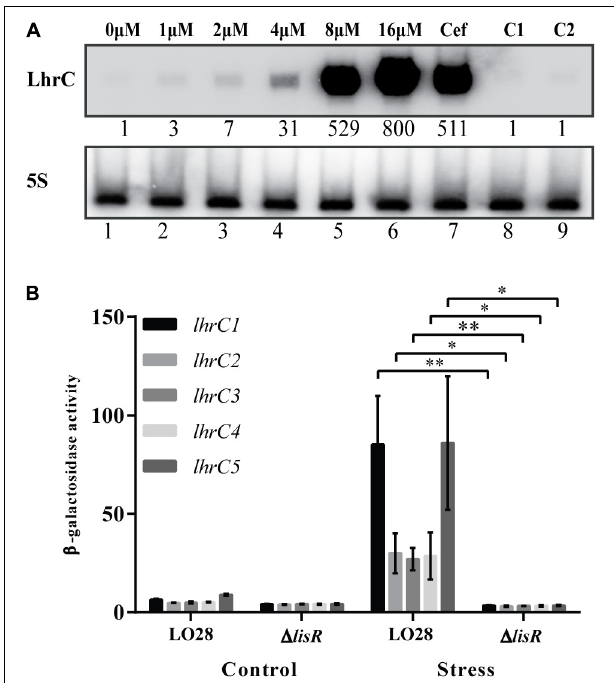
FIGURE 1 | Induction of LhrC1–5 during hemin stress. (A) Northern blot analysis of LhrC1–5 expression. Samples were taken from Listeria monocytogenes LO28 wild-type cultures stressed with increasing concentrations of hemin (lanes 1–6), with a sub-inhibitory concentration of cefuroxime (9 µ M) (lane 7) or with the hemin dissolvent NaOH (the same volume used to dissolve 8 and 16 µ M hemin – lanes 8 and 9, respectively). Northern blot was probed for LhrC1–5 and 5S rRNA as a loading control. Relative levels of LhrC1–5 (normalized to 5S) are shown below each lane. (B) Transcriptional reporter gene fusions of lhrC promoters. Plasmids containing each of the five lhrC promoter regions fused to lacZ (Sievers et al., 2014) were transformed into LO28 wild-type and (cid:49) lisR . The resulting strains were grown up to OD 600 = 0.35 and stressed with hemin (8 µ M), after control samples had been taken (Control). Further samples for a following β -galactosidase assay were withdrawn after 2 h (Stress). Results are the average of three biological replicates, each carried out in technical duplicates. After 2 h of stress, a significant difference between the (cid:49) lisR mutant and wild-type cells was observed ( ∗ p < 0.05, ∗∗ p <